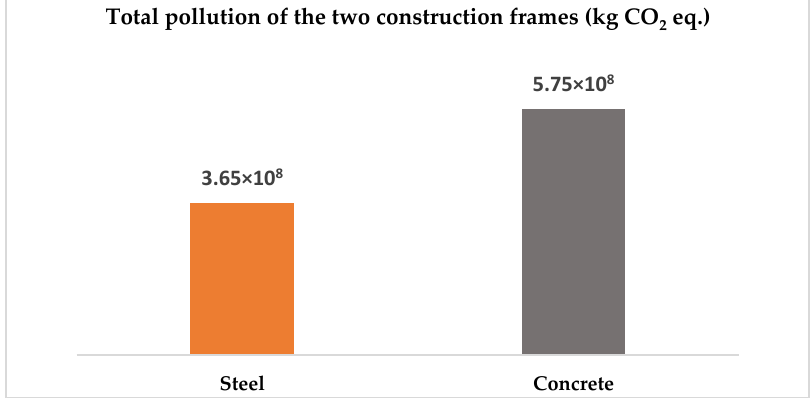
Figure 2. Total environmental pollution [37].